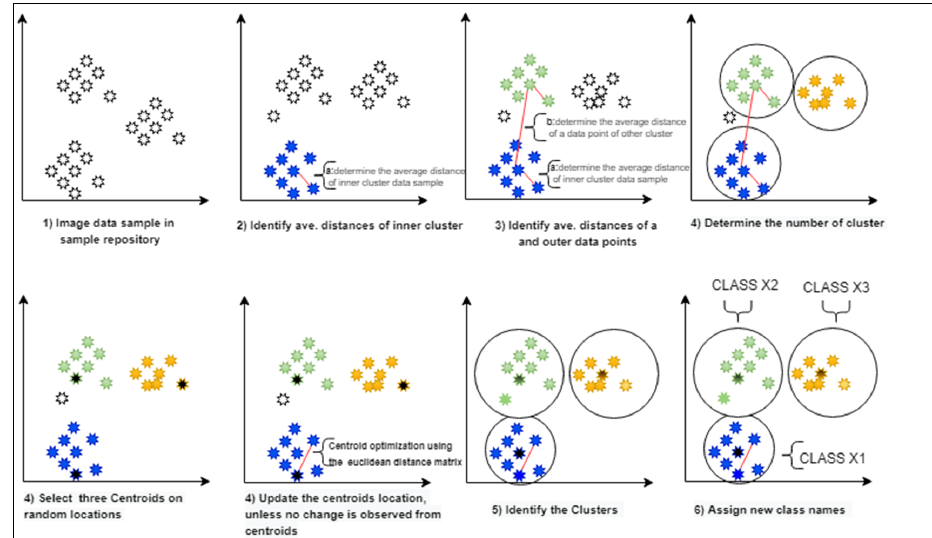
Figure 3. A proposed clustering approach to determine the new classes from the unknown image